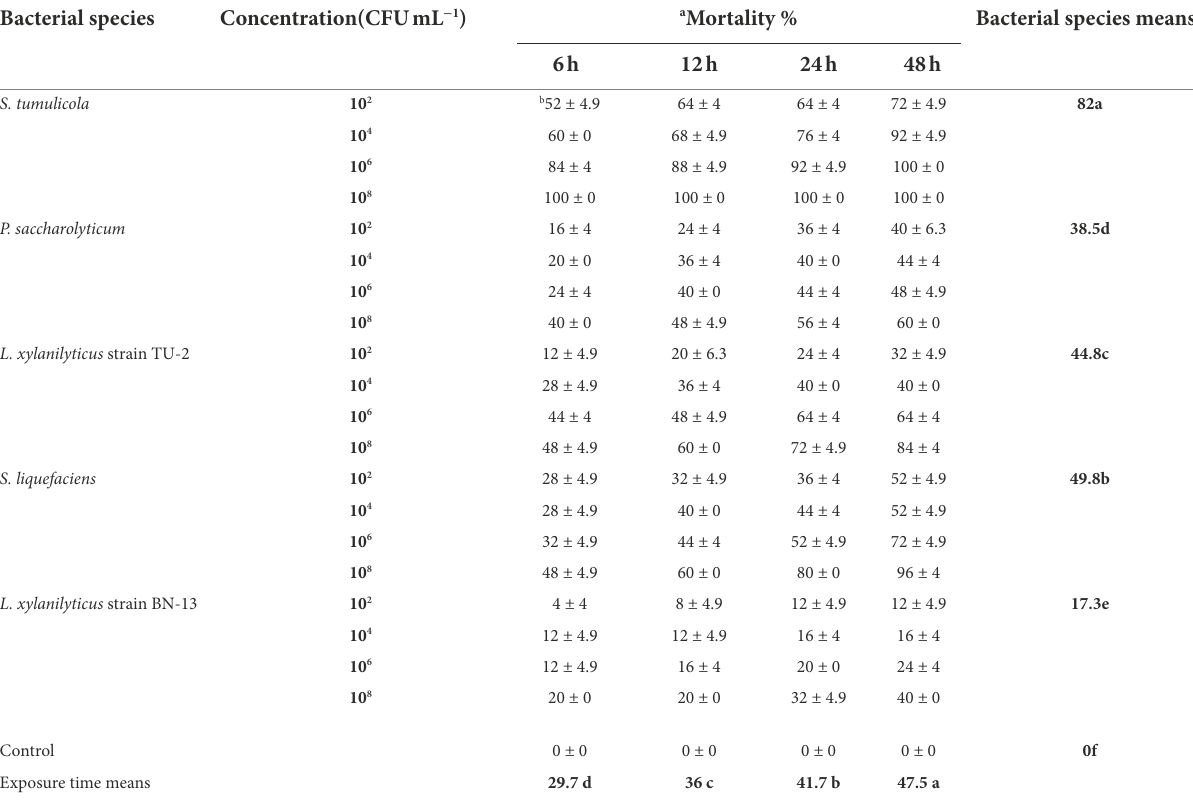
TABLE 4 Aphicidal activity of five bacterial species cells on the pomegranate aphid, A. punicae under laboratory condition. Bacterial species